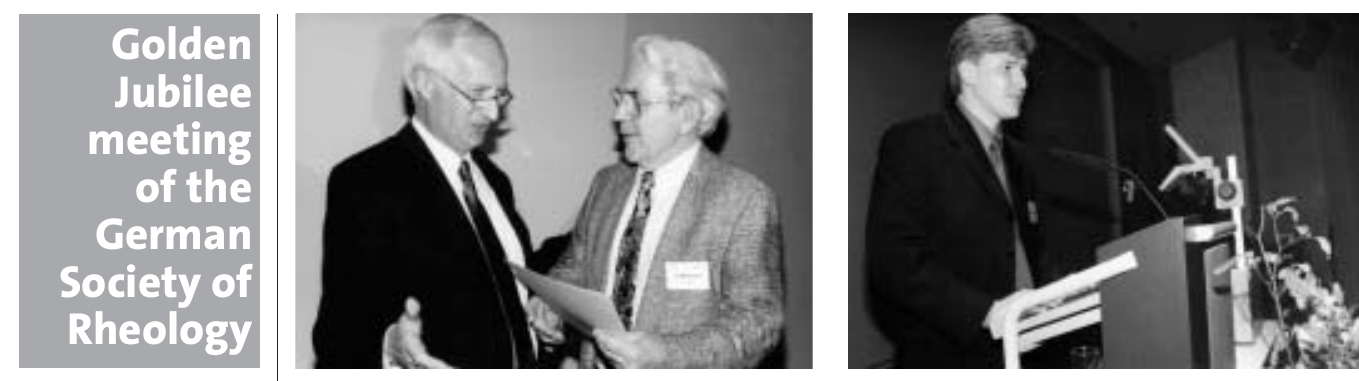
Figure 4 (left): M. Wagner and J. Meissner Figure 5 (right): M. Schmidt Figure 6 (above) : Prof. Dr. Max Pfender (right) togeth- er with Prof. Dr. K. Kirschke Figure 7 (below): The president as local artist and a “Berliner